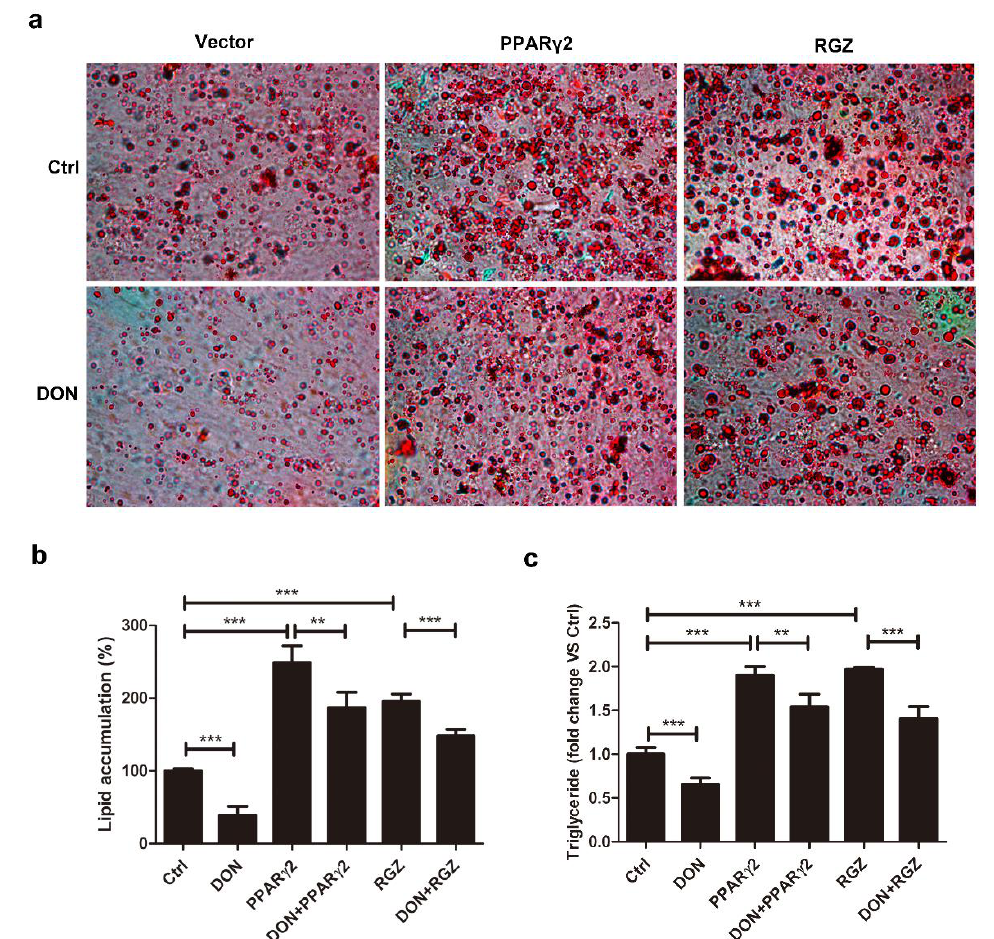
Figure 3. PPARγ2 overexpression attenuated the DON-induced inhibition of adipogenesis in 3T3-L1 cells. 3T3-L1 preadipocytes were transfected with PPARγ2 or treated with RGZ (1 μM) and then cultured in DMEM + FBS medium containing the differentiation cocktail with or without DON (100 ng/mL) for 7 days. ( a ) Oil Red O staining. The cells were photographed at ×100 magnification. ( b ) Quantification of lipid accumulation. ( c ) TG levels. The results are representative of three independent experiments, and statistical significance is indicated by ** p < 0.01, *** p < 0.001.